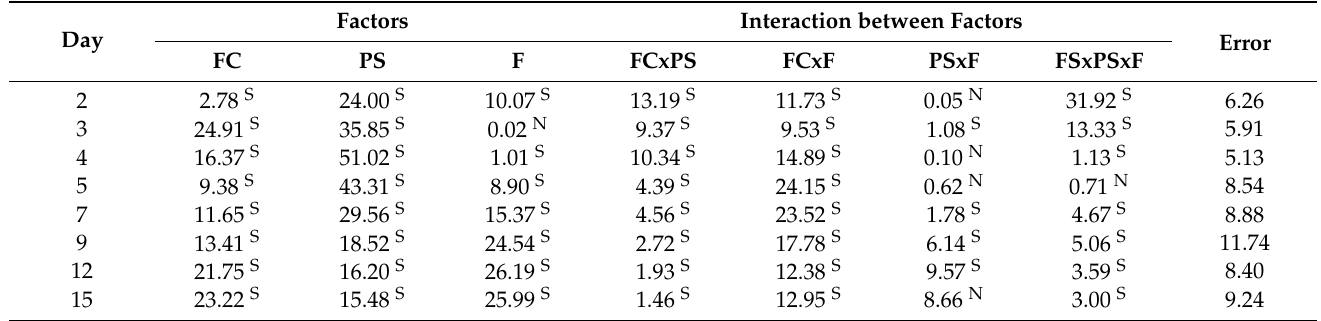
Table 4. The influence percentage of individual factors and their interactions affecting the mold growth on HDPE composites.